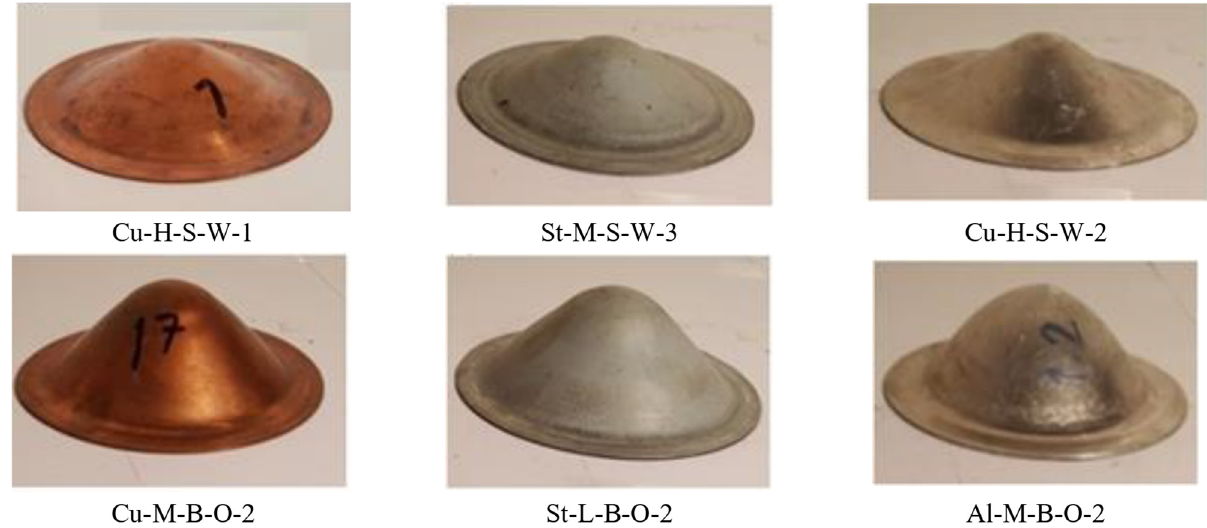
Fig. 7. Experimental deformation modes for some